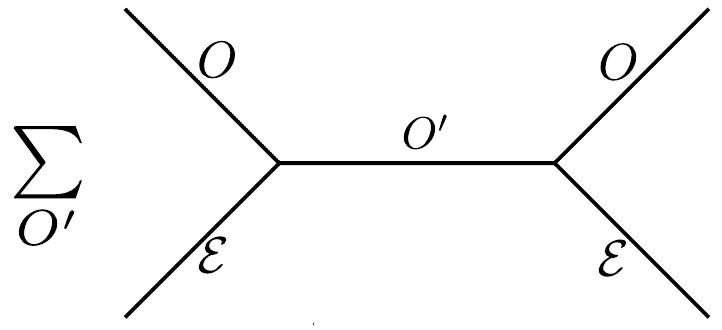
Figure 2 . The OPE expansion of the four-point function in the channel we have picked. To compute the correlator to the (cid:12)rst two orders in 1 =N 2 , the sum over O 0 is over all single-trace and double-trace